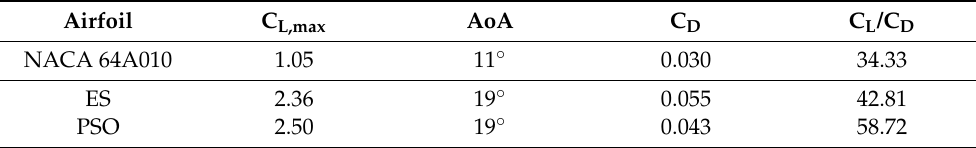
Table 7. Comparison of aerodynamic characteristics at the C L,max angle of attack. Lift, drag, angle of attack, and aerodynamic performance are presented for the initial NACA 64A010 and the morphed PSO and ES airfoils.